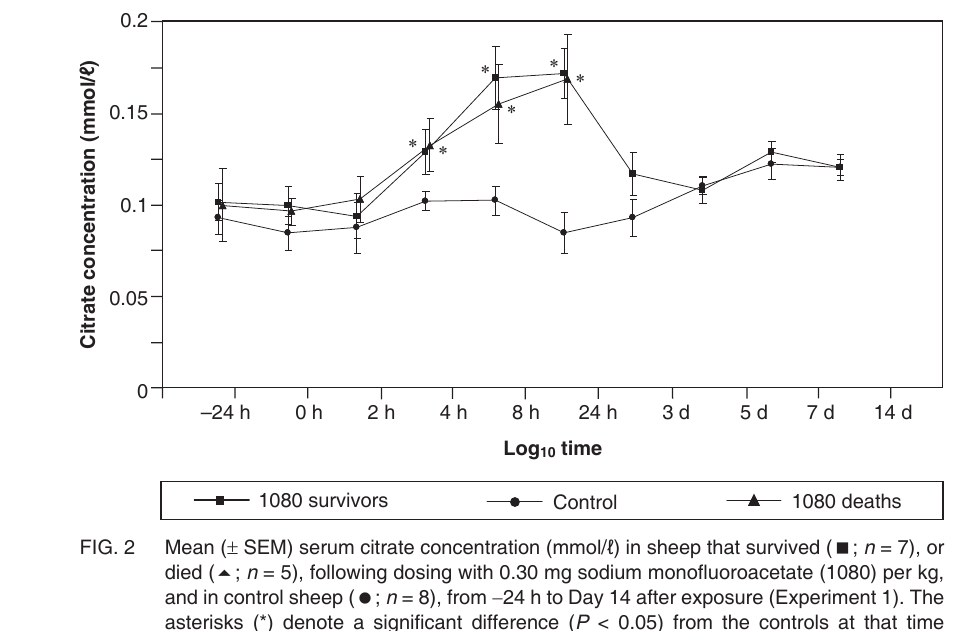
1080 survivors Control 1080 FIG. 2 Mean ( ± SEM) serum citrate concentration (mmol/ ℓ ) in sheep that survived ( (cid:31) ; n = 7), or died ( (cid:24) ; n = 5), following dosing with 0.30 mg sodium monofluoroacetate (1080) per kg, and in control sheep ( (cid:32) ; n = 8), from − 24 h to Day 14 after exposure (Experiment 1). The asterisks (*) denote a significant difference ( P < 0.05) from the controls at that time period